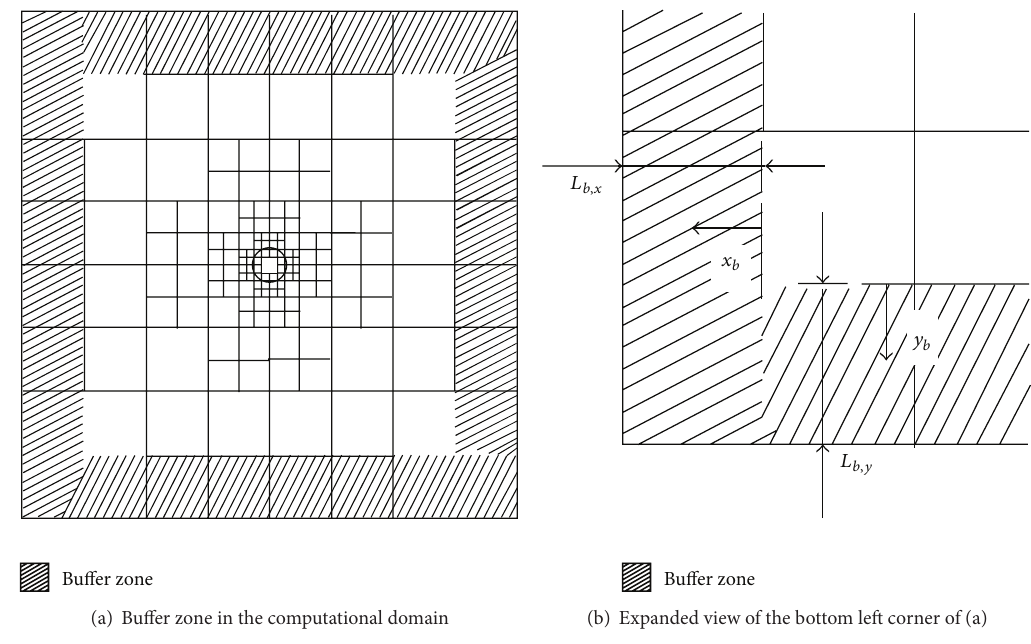
Figure 5: Buffer zone boundary